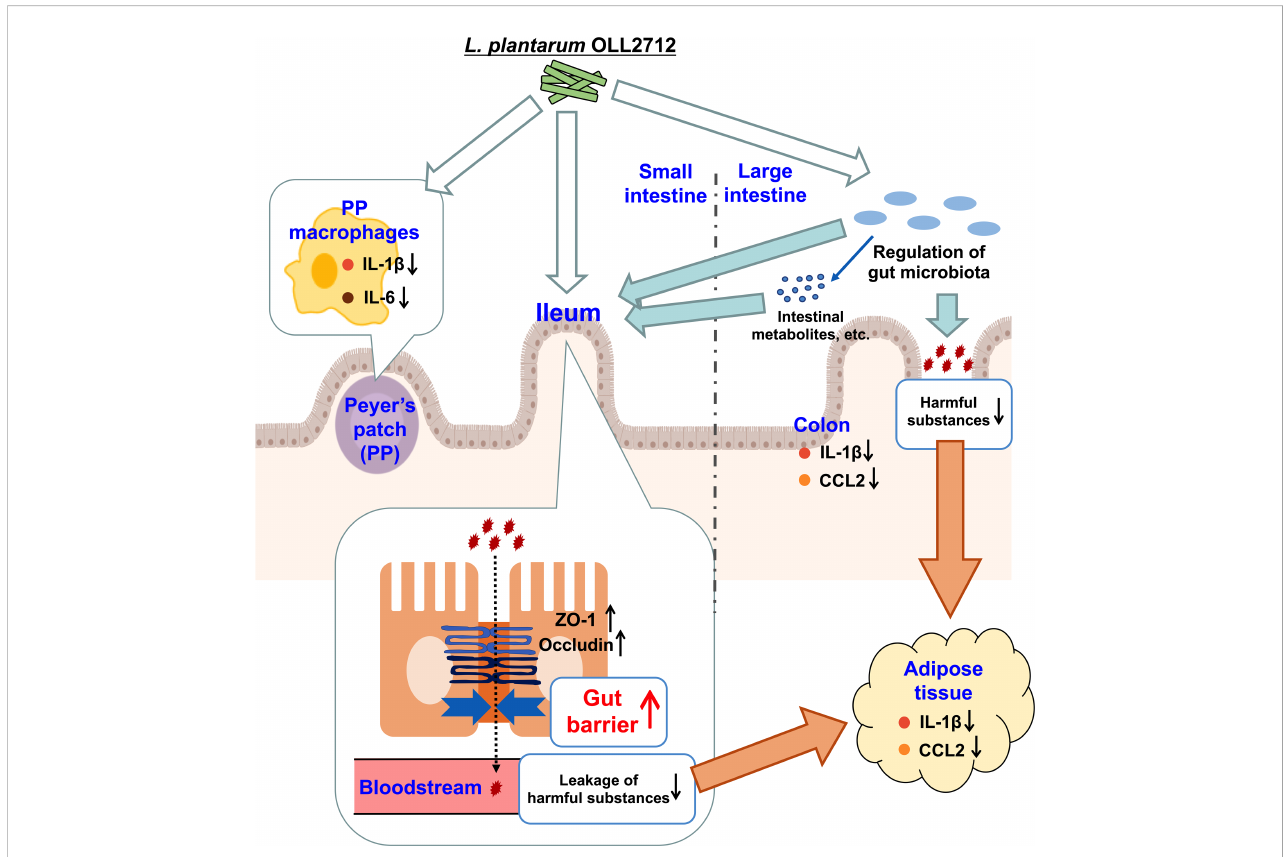
FIGURE 6 The pathways by which the lactic acid bacteria (LAB) strain exerted its anti-in fl ammatory effects. Ingested OLL2712 might directly regulate the gut microbiota in the large intestine and reduce harmful substances, which are derived from obesity-induced gut dysbiosis and leak into the blood, eventually relieving adipocyte in fl ammation. Simultaneously, the LAB strain enhanced the intestinal barrier, especially in the ileum, suggesting collaborative modulation of intestinal immune responses by ingested lactic acid bacteria and microbiota. The enhancement of the gut barrier reduced the leakage of harmful substances into the bloodstream, which resulted in anti-in fl ammatory changes in the adipose